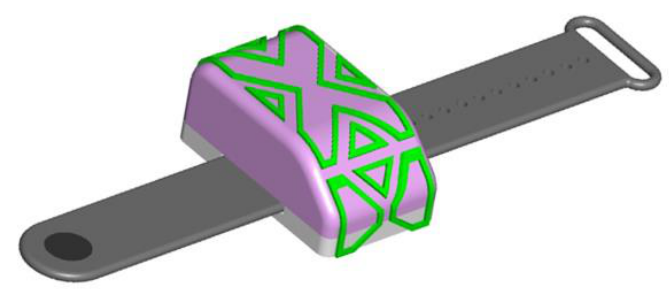
Figure 8. Motion sensor system hardware container developed.